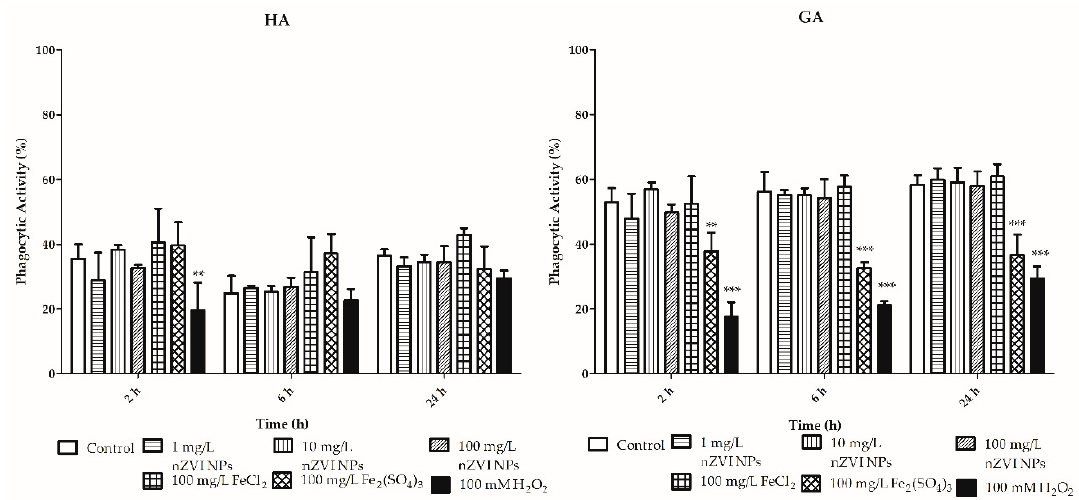
Figure 8. Phagocytic activity of hyaline (HA) and granular (GA) amoebocytes after exposure to nZVI NPs, FeCl 2 and Fe 2 (SO 4 ) 3 for 2, 6 and 24 h; 100 mM H 2 O 2 was used as a positive control; * p < 0.05, ** p < 0.01, *** p < 0.001.